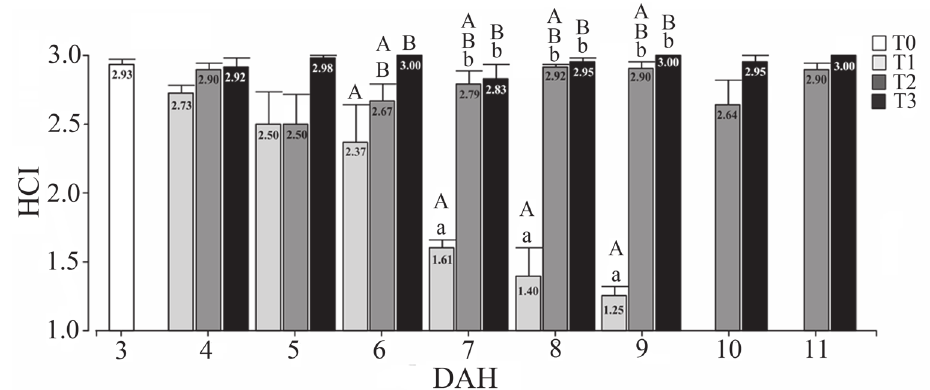
Fig. 5. Mean histological condition index (HCI) and standard error for Pagrus pagrus larvae from the feeding treatments against larval age expressed as days after hatching (DAH). Different lowercase letters indicate significant differences (p<0.05) among feeding treatments, after one way ANOVA followed by post-hoc Tukey’s test. Different capital letters indicate significant differences (p<0.05) among feeding treatments, after Kruskal Wallis test followed by multiple comparisons. T0: before the experiment begins, T1: without food, T2: delayed feeding and T3: fed.